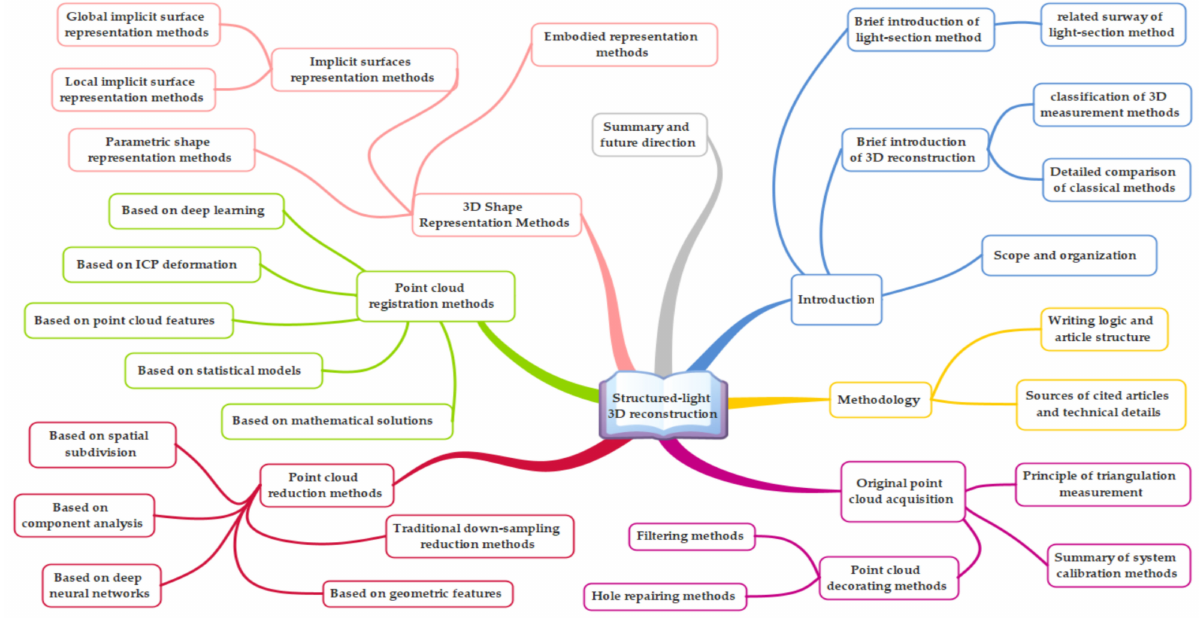
Figure 4. Structure of this review about high-precision 3D reconstruction utilizing line-structured light